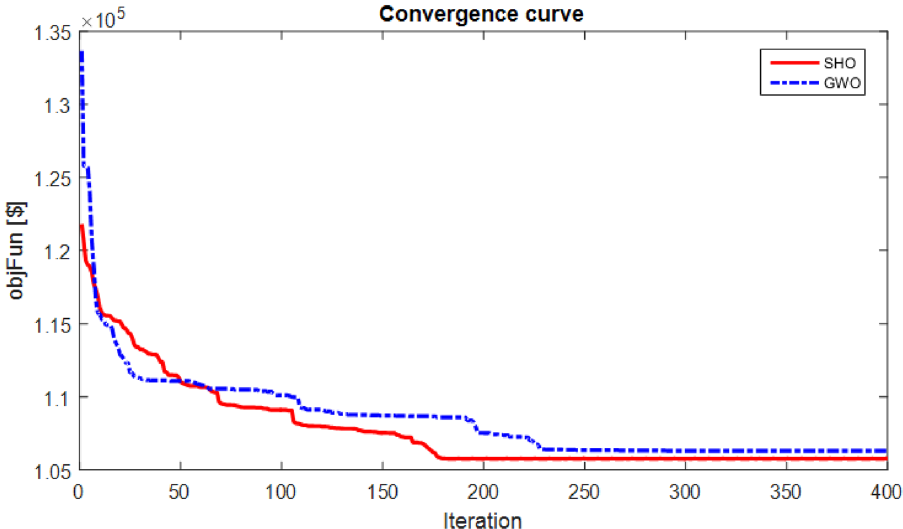
Figure 2. The convergence process of optimization methods for the 24-bus network with cosφ = 1.